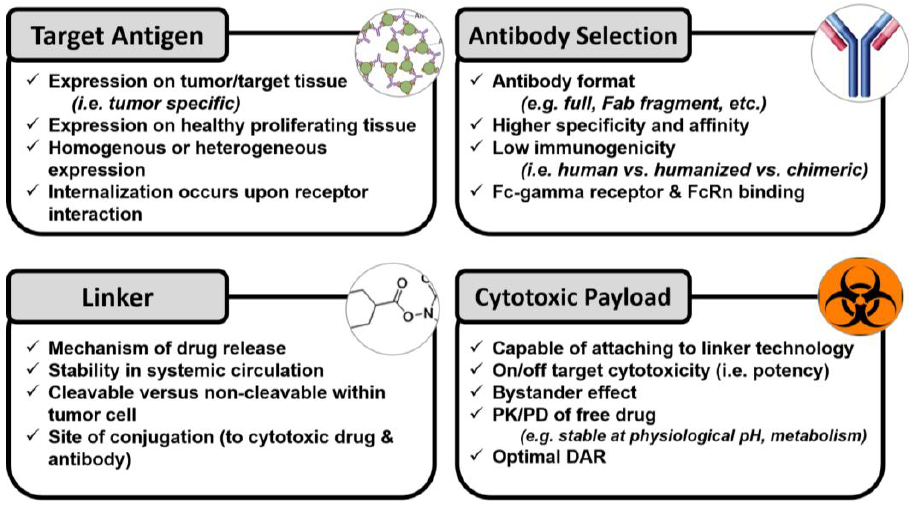
Figure 1. Considerations in the design and development of antibody–drug conjugates that affect the pharmacokinetics and pharmacodynamics of the agents. PK, pharmacokinetic;